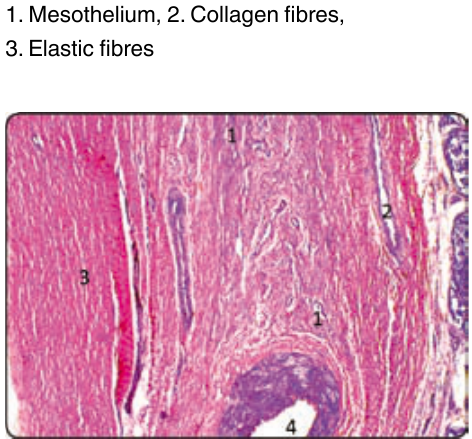
Fig. 3. Cross section of testicular capsule with visceral layer of tunica vaginalis. Gomori’s method for reticular fibres x 100